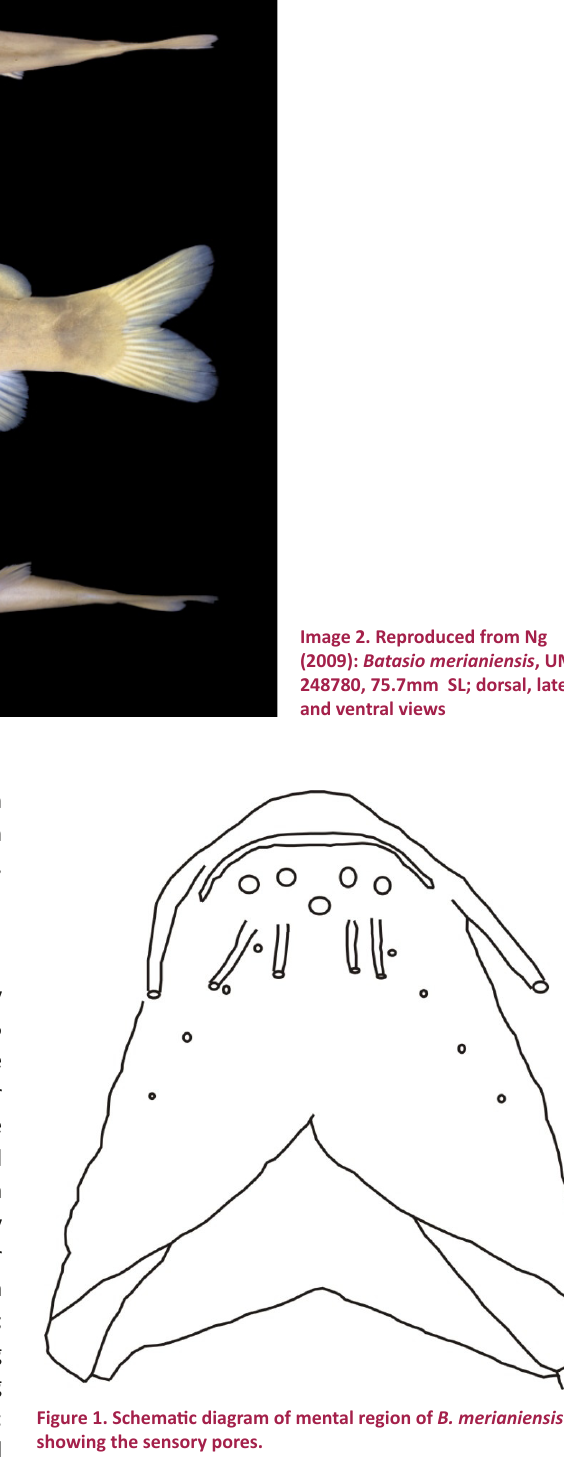
Distance between pectoral-fin and pelvic-fin origin and between dorsal-fin and pelvic-fin origin is equal. Eye